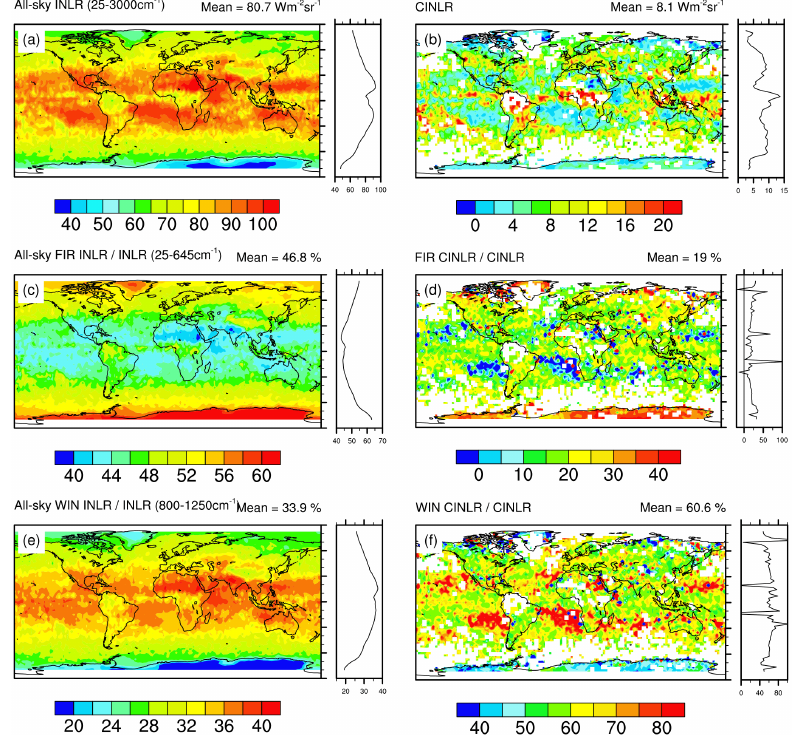
Figure 14. INLR and CINLR maps created from all April 2012 pixels binned to a 2.5 by 2.5 grid and averaged. Zonal means are shown to the right of each map. On the left-hand side is all-sky: (a) INLR, (c) FIR as a percentage of INLR, (e) the window region as a percentage of INLR. On the right is CINLR (clear-sky–all-sky) for (b) INLR, (d) the percentage of CINLR that is FIR, (f) the percentage of CINLR that is in the window region. Note that the colour scales are different for every panel. Missing data are shown in